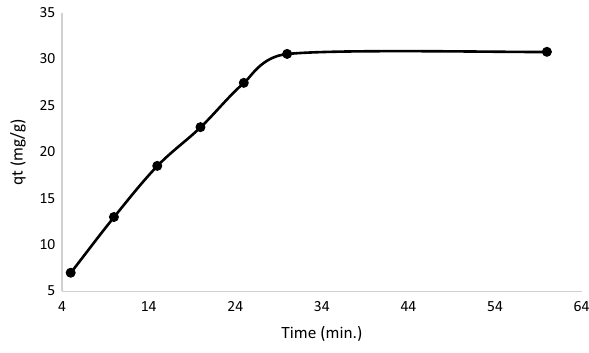
Fig. 6 Adsorption capacity of AgNPs for the removal of Rh-B at dif- ferent contact times. 1 g/l of AgNPs in 100 ml of 50 mg/l Rh-B, agi- tation speed—150 rpm at 303 K, pH 3.4